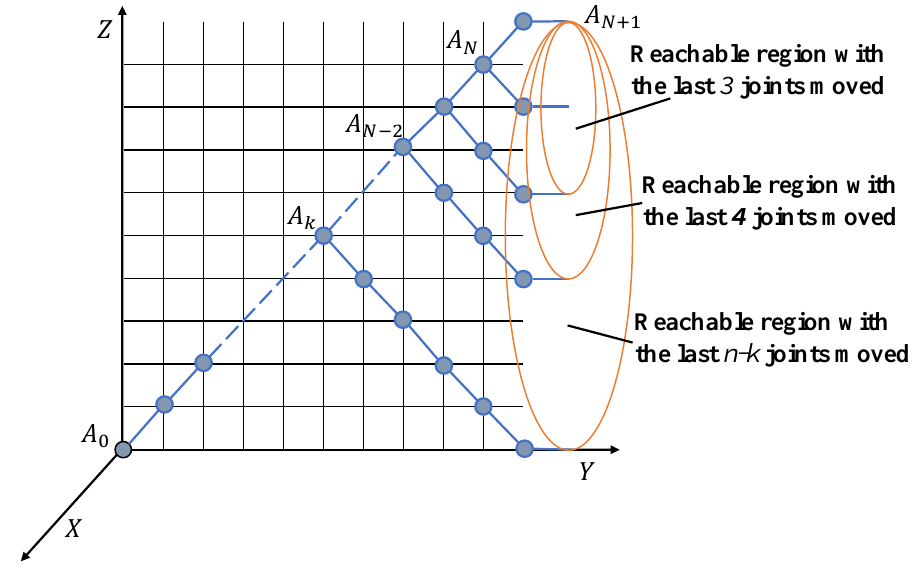
Figure 5. Simplified kinematics model between joint angles and end-effector position.